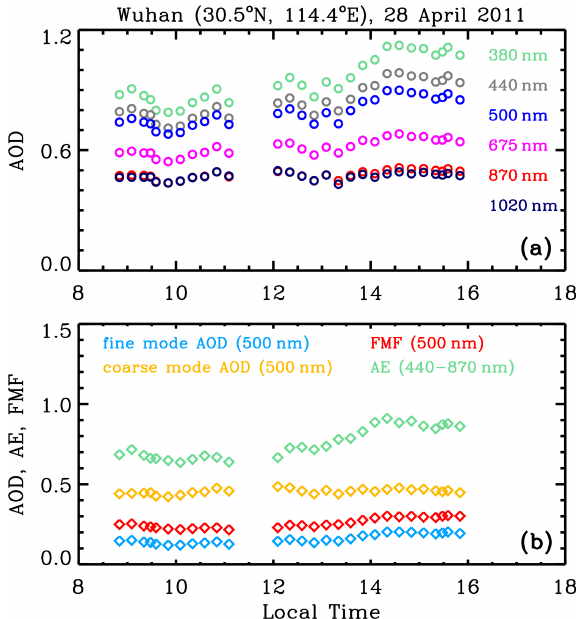
Figure 4. Time series of (a) AOD at six wavelengths (380, 440, 500, 675, 870, 1020nm) and (b) 500nm fine-mode AOD (azure rhombi), coarse-mode AOD (yellow rhombi), fine-mode AOD fraction (FMF, red rhombi), and Ångström exponent for the 440–870nm wave- length range (AE, aquamarine rhombi) observed with a sun pho- tometer at Wuhan (30.5 ◦ N, 114.4 ◦ E) on 28 April 2011. correlation coefficient of 0.976 for the period of 2011–2013.